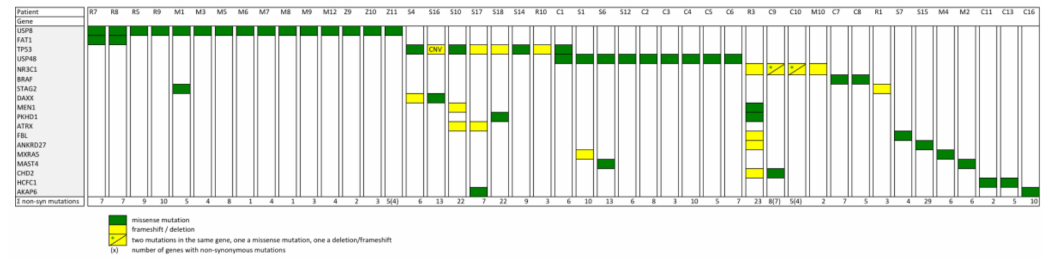
Figure 3. Schematic representation of all recurrent mutations, both independent and dependent, identified by next generation sequencing until now in Cushing’s disease. In the left column is the list of genes and in the upper line are listed the di ff erent samples in which the mutations have been identified. The letters are coding for the di ff erent studies R = Reincke et al. [15], M = Ma et al. [16], Z = Song et al. [27], S = Sbiera et al. [18], and C = Chen et al. [17], while the numbers indicate the individual samples as listed in the original